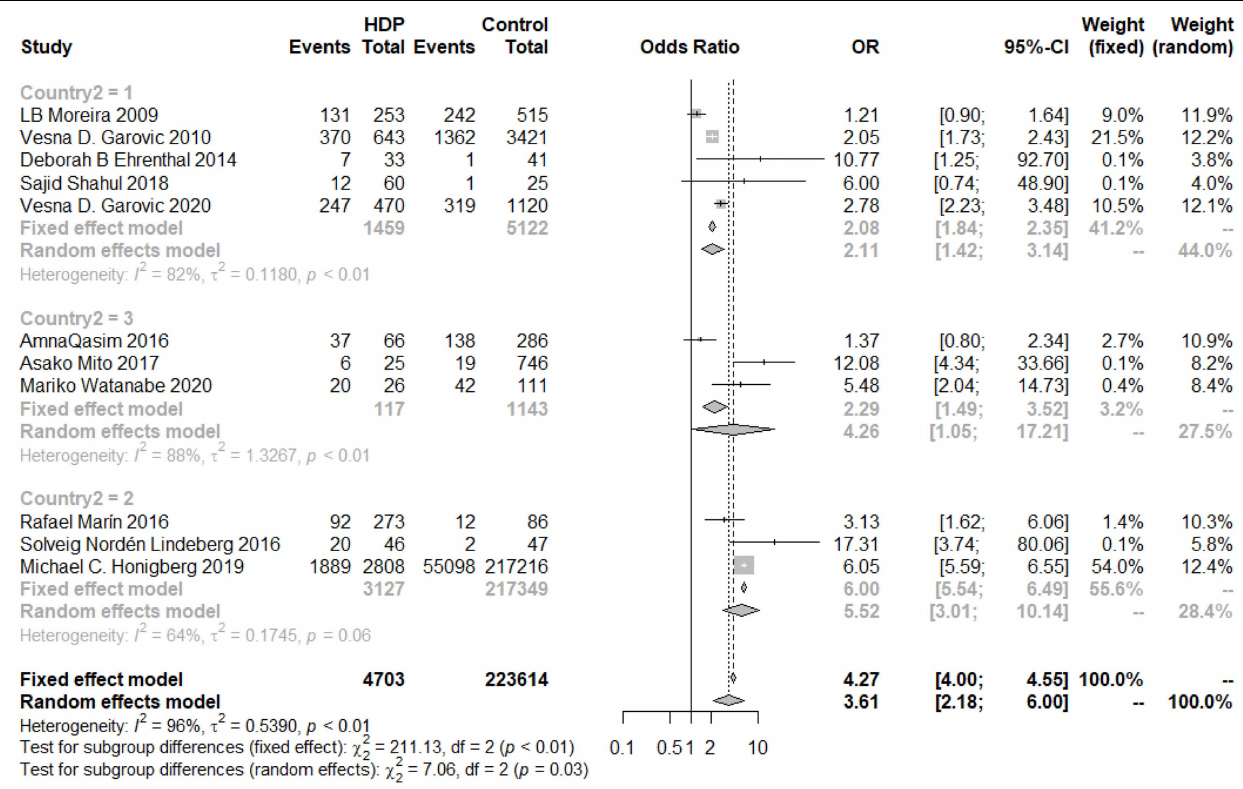
FIGURE 6 | Subgroup analysis by region of the risk of developing chronic hypertension in the HDP group (1 = North and South America, 2 = Europe, 3 = Asia).